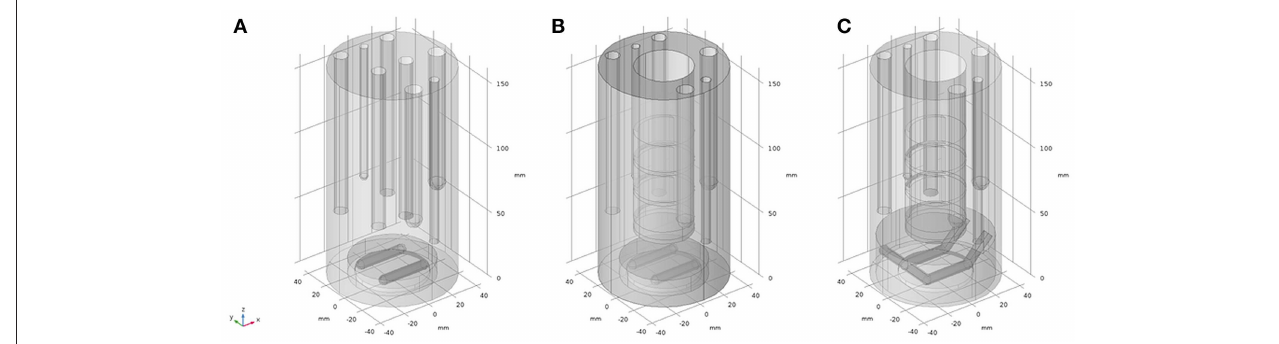
FIGURE 3 | CAD geometry representations of the reactor setups used for finite element modeling; (A) model used for representation of setup 2; (B) model used for representation of setup 3; (C) model used for representation of setup